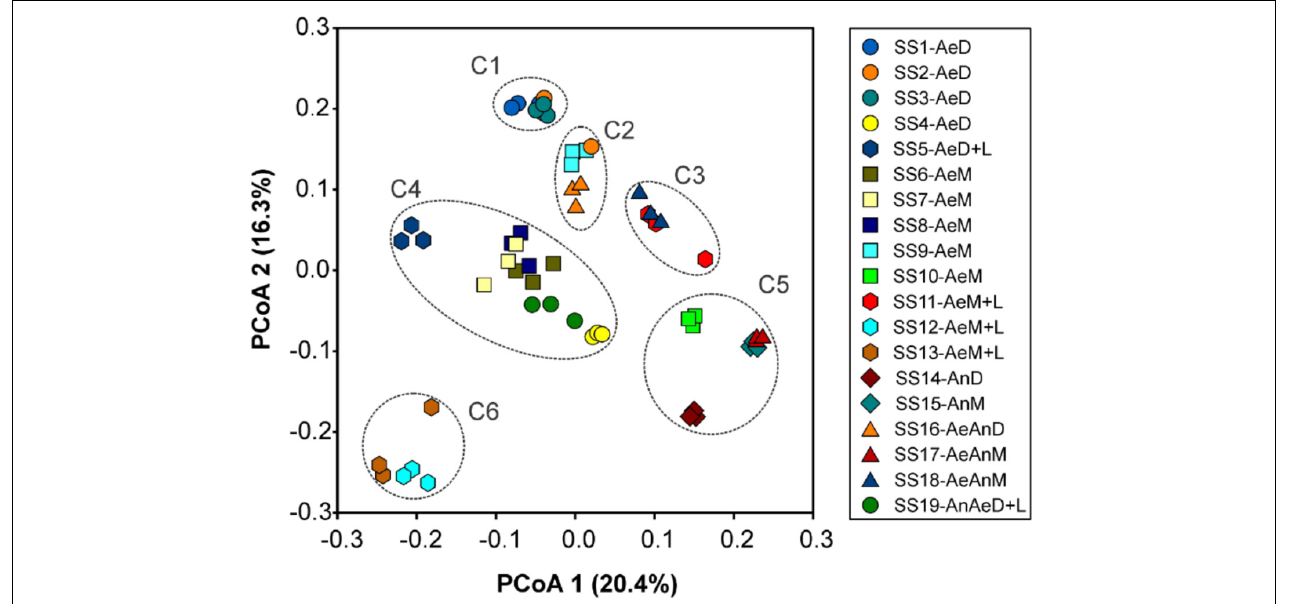
FIGURE 2 | Principal coordinate analysis (PCoA) for bacterial community structure of 19 sewage sludges from São Paulo State, Brazil ( n = 3). Axis values indicated percentage of variance.